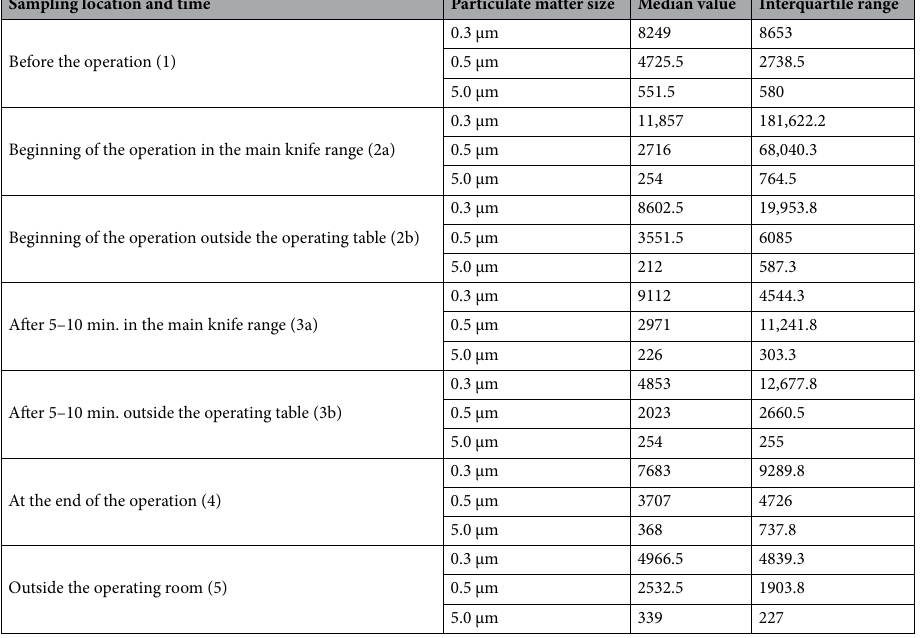
Sampling location and